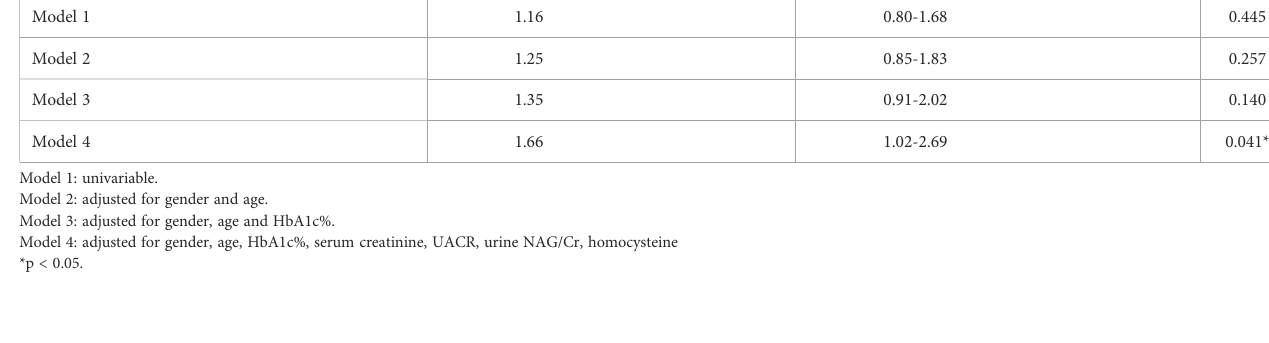
TABLE 6 Relationship between anemia and rapid eGFR decline.